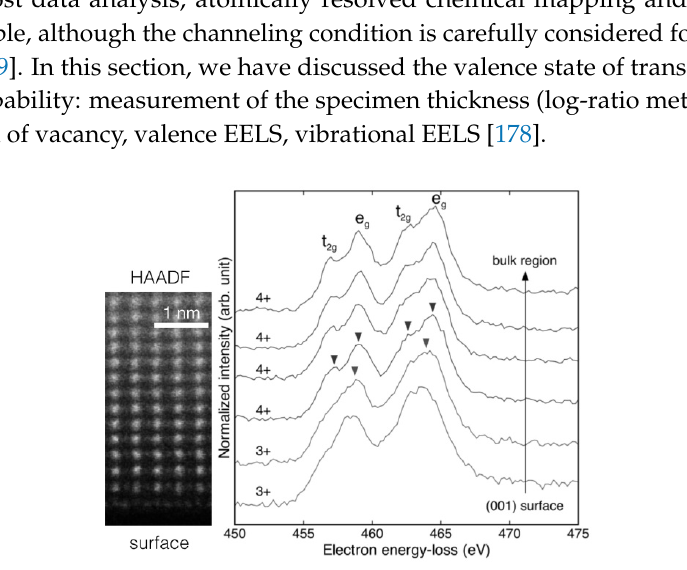
Figure 20. HAADF STEM image and core-loss EELS of Ti-L edges from the surface to the bulk with 1 nm step, where the specimen is LaTiO 2 N and the orientation is [100] direction. 1 nm step, where the specimen is LaTiO 2 N and the orientation is [100]